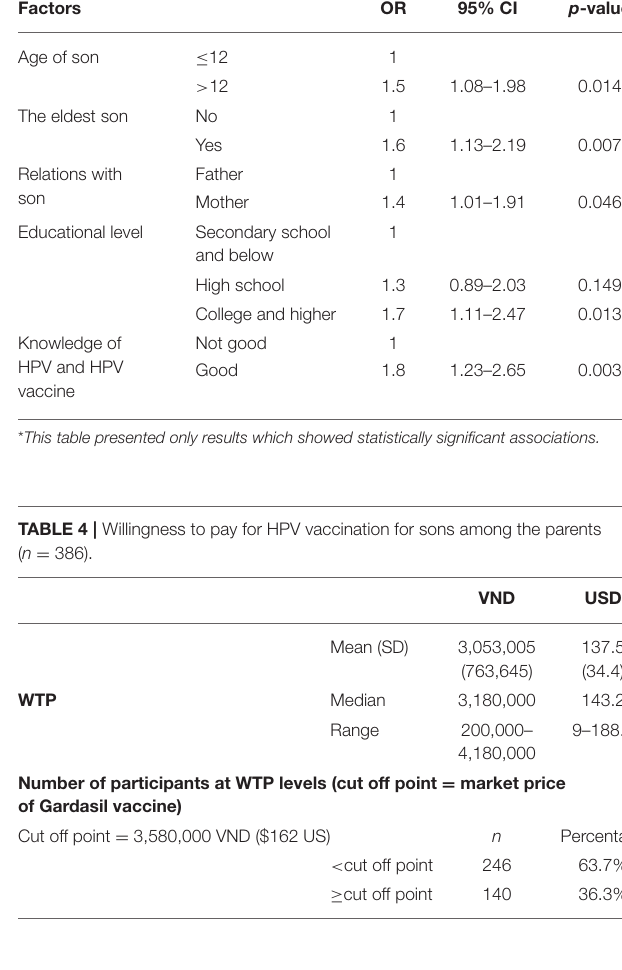
TABLE 3 | Factors related to acceptability of parents for HPV vaccination for their sons*. Factors